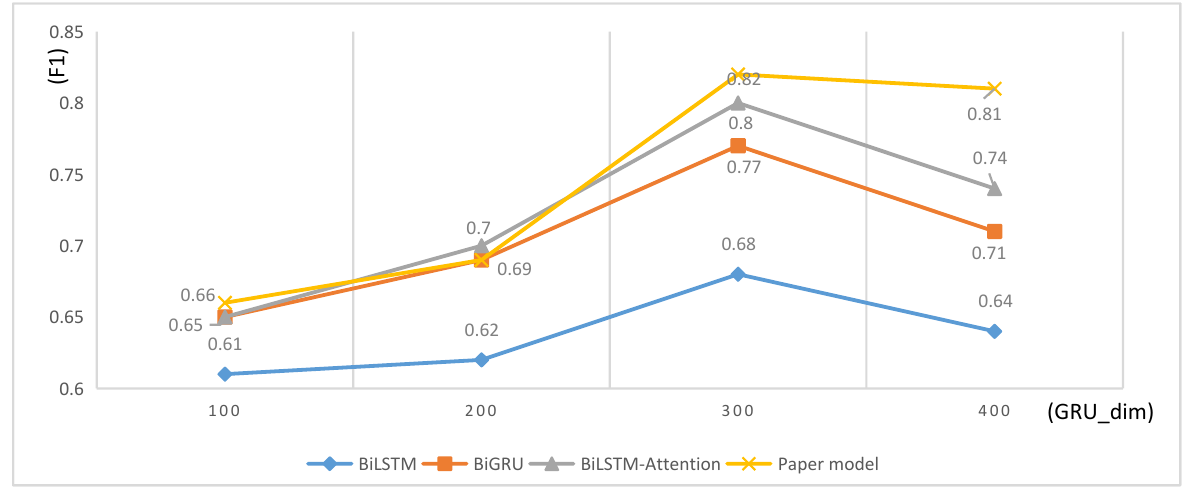
Figure 19. Comparison of relation extraction models experimental results in different dimensions.